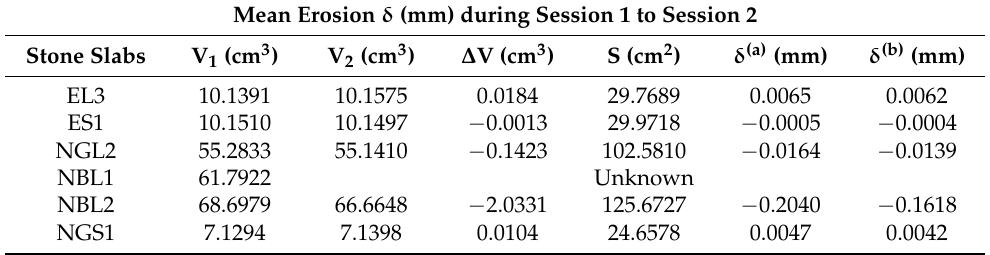
Table A3. Estimated erosion by volume and surface area computation of the selected stone slabs. Mean Erosion δ (mm) during Session 1 to Session 2 Stone